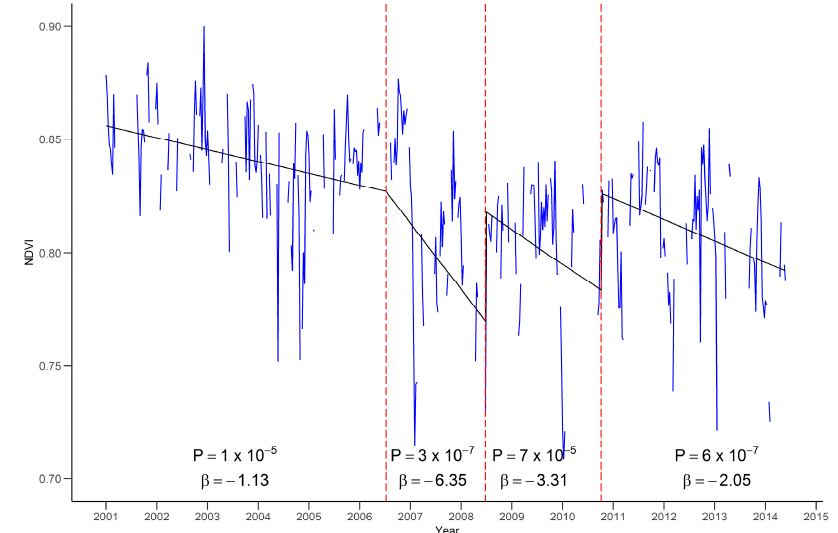
Figure 2. Example Breaks for Additive Season and Trend (BFAST) output of a browning pixel. Three major breakpoints (dashed red lines) and four segments (black lines) have been identified over the 13.5-year Multi-Angle Implementation of Atmospheric Correction (MAIAC) time series (blue lines) with missing observations due to cloud effects. The slope coefficients ( β ) are all significant ( α = 0.05) and ρ represents p -values.